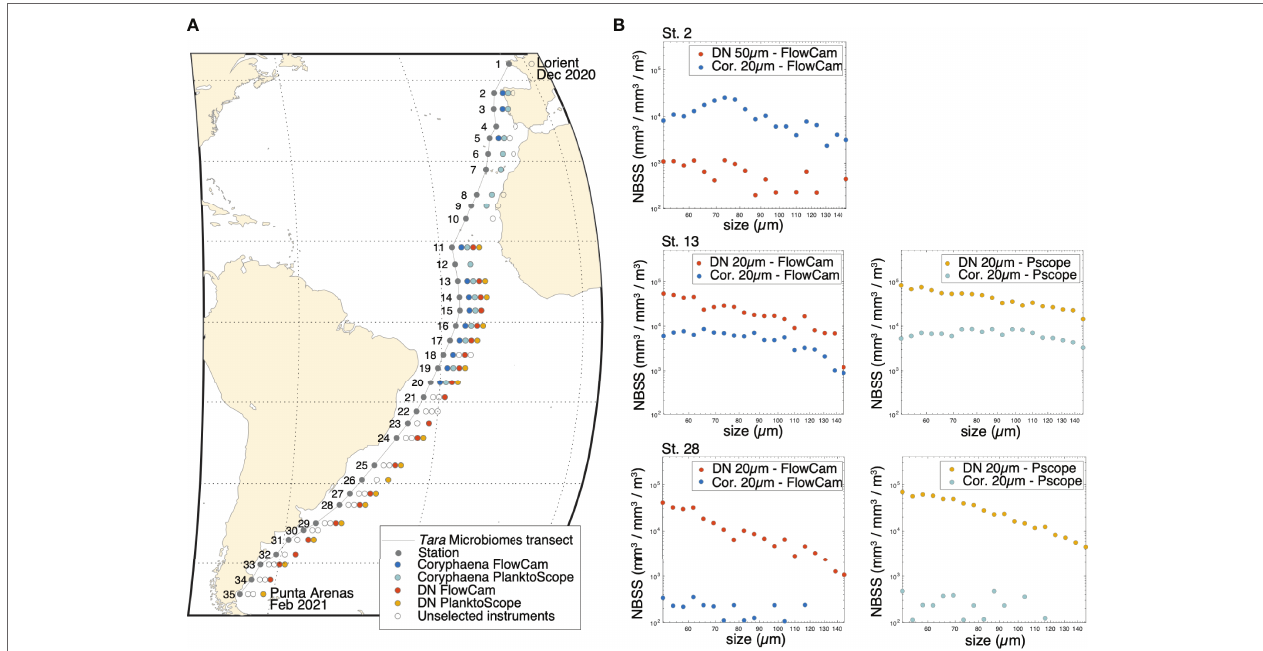
FIGURE 2 | (A) Map of the Tara Mission Microbiomes Atlantic transect. The colored dot (see legend) indicates instruments’ configuration deployed at each of the 35 daily stations (gray dots). (B) Examples of Normalized Biovolume Size Spectra (NBSS) displaying the number of live organisms per size class (in mm 3 mm -3 m -3 ) sampled by each net (DN - Decknet; Cor. - Coryphaena ), at stations 2, 13 and 28. The comparison of the number of live organisms sampled between the two nets is shown for both FlowCam and PlanktoScope (Pscope) analyses at stations 13 and